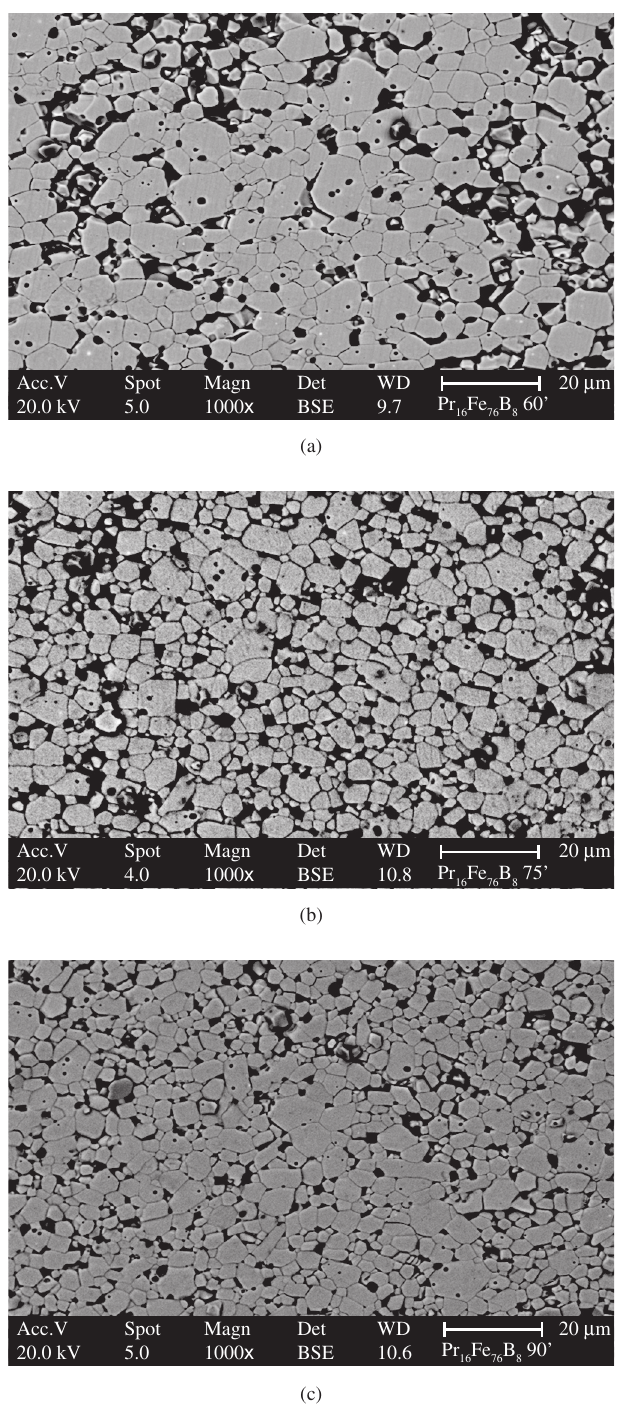
Figure 6. General view of the microstructure of Pr from the decrepitated ingot milled at 200 rpm for a) 3.6; b) 4.5; and c) 5.4 ks.